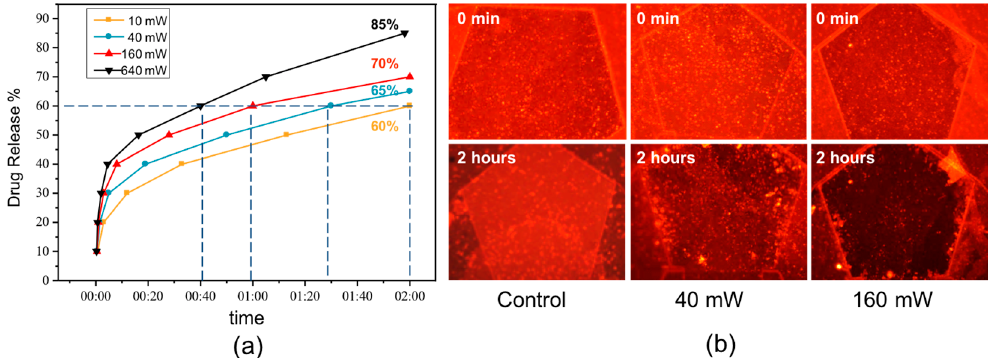
Figure 3. ( a ) DOX release under the stimulus of the resonator with different power inputs; ( b ) Fluorescence images of the thin films taken before and after the experiments.